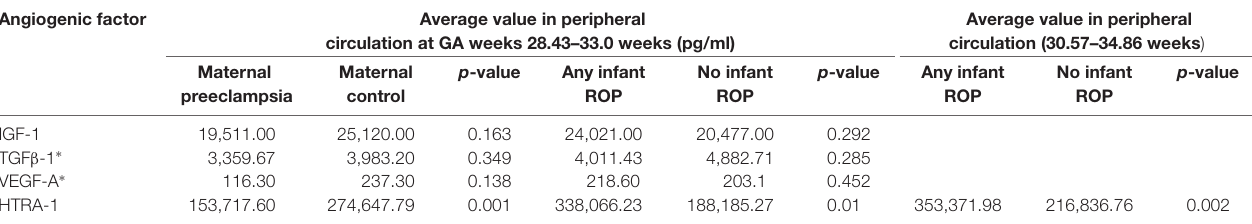
TABLE 3 | Average preterm infant systemic values of candidate angiogenic factors by ELISA or Luminex ∗ . Angiogenic factor